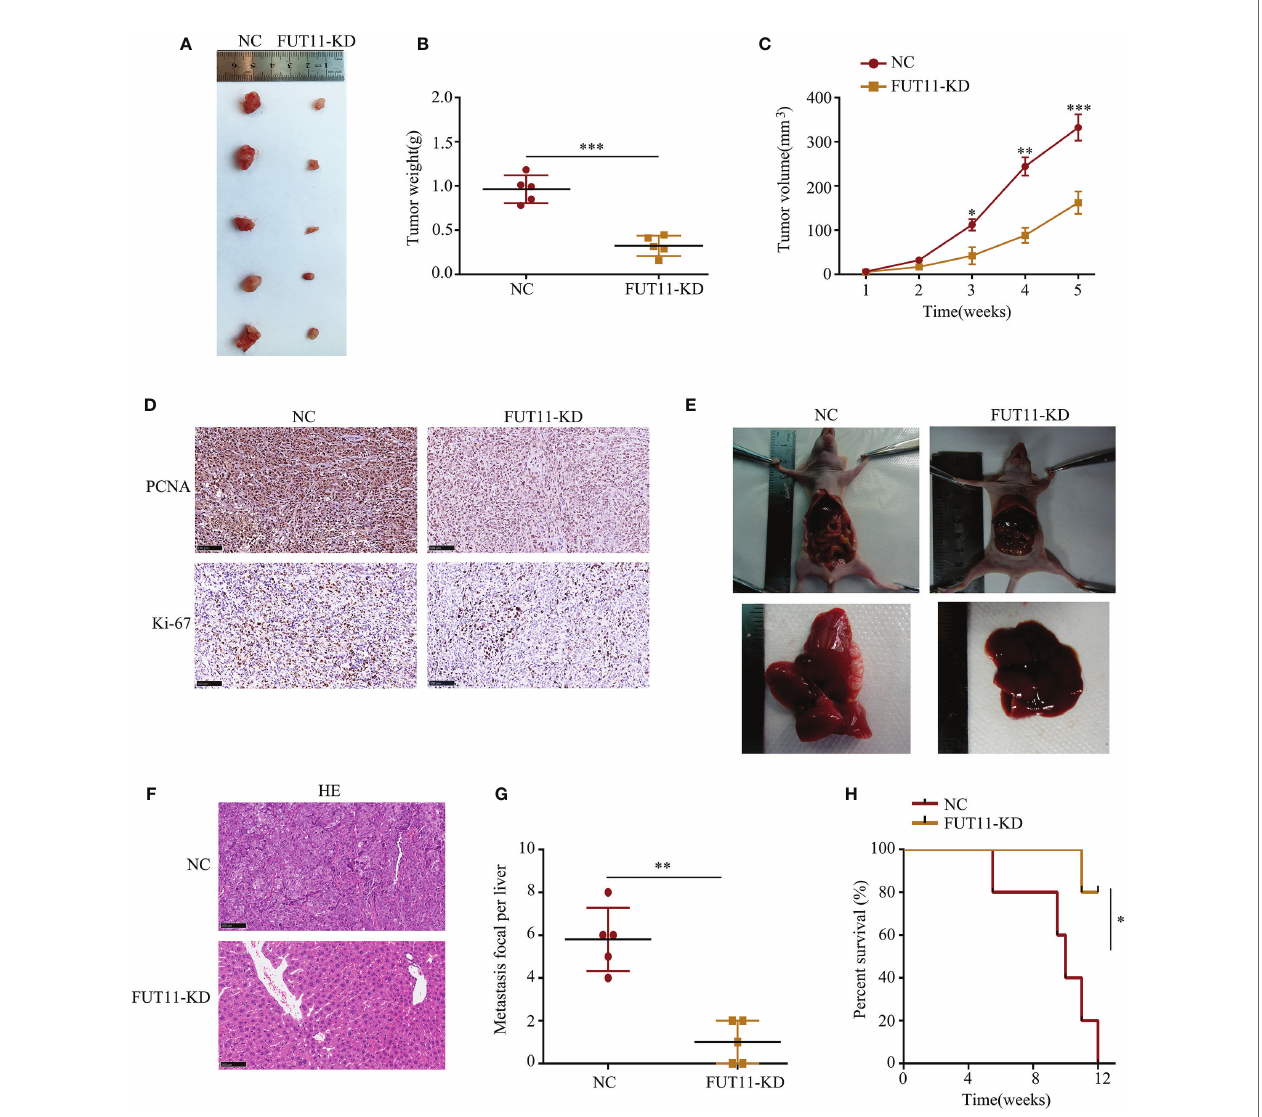
FIGURE 4 | Inhibition of FUT11 suppressed the proliferation and metastasis of PANC-1 cells in vivo . (A) Representative image of tumor tissues in negative control group and FUT11 knockdown group. (B) The mean tumor weight of FUT11 knockdown and negative control groups. (C) The proliferative rate of tumor tissues with FUT11 knockdown and negative control. (D) IHC staining of Ki-67 and PCNA protein expression in transplanted tumors under different experimental conditions. (E) Live metastatic tumor model (n=5). (F) IHC staining and HE images showing the metastatic foci in liver in indicated groups. (G) Statistical analysis of the average numbers of visible liver metastatic foci. (H) Kaplan – Meier survival curves for each experimental group, (n=5). * P < 0.05; ** P < 0.01; ***P <